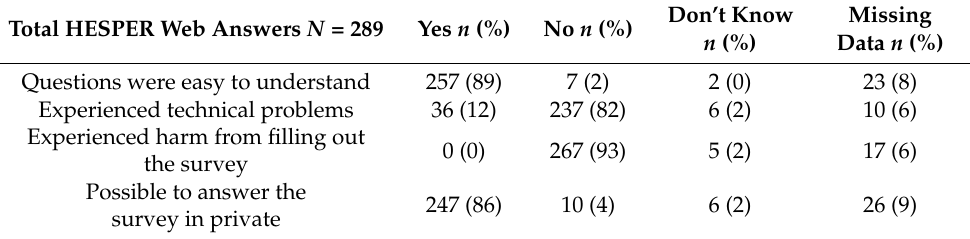
Table 4. Feasibility evaluation questions for HESPER Web.